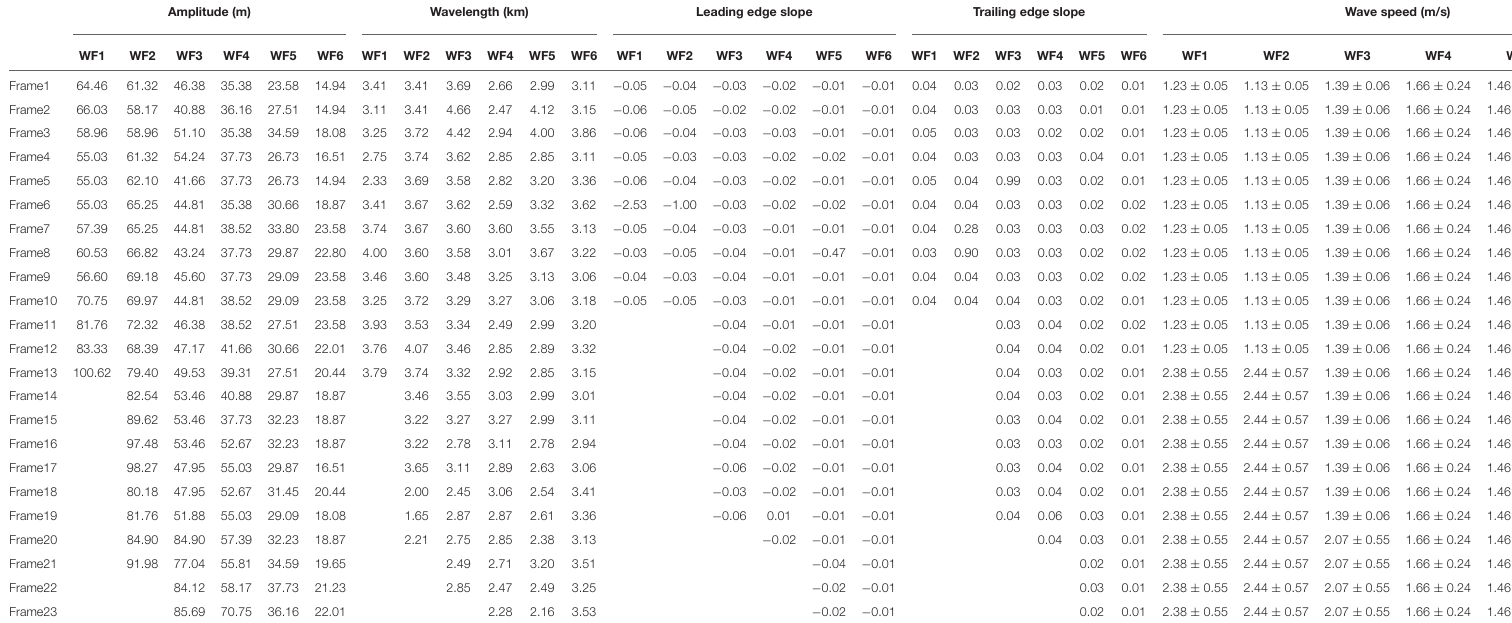
TABLE 1 | The four parameters of the internal solitary wave calculated from seismic